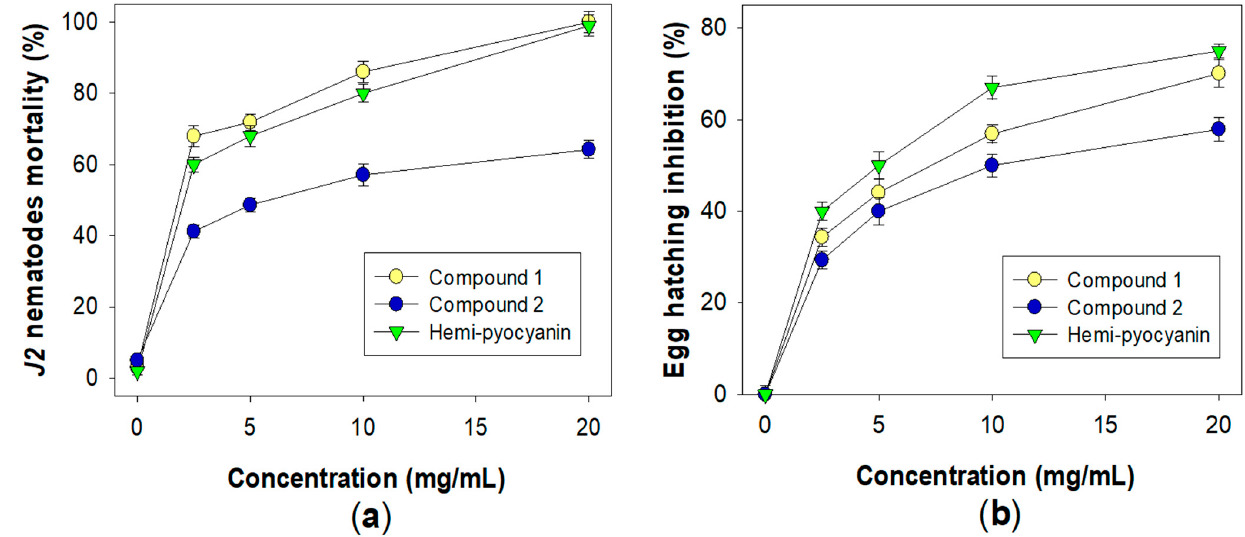
Figure 3. The nematicidal effects of purified thymine (compound 1 ), hexahydropyrrolo [1,2-a] pyrazine-1,4-dione (compound 2 ), and hemi-pyocyanin (an antinematode compound used as the positive control). The J2 nematodes mortality ( a ) and egg-hatching inhibition effect ( b ).